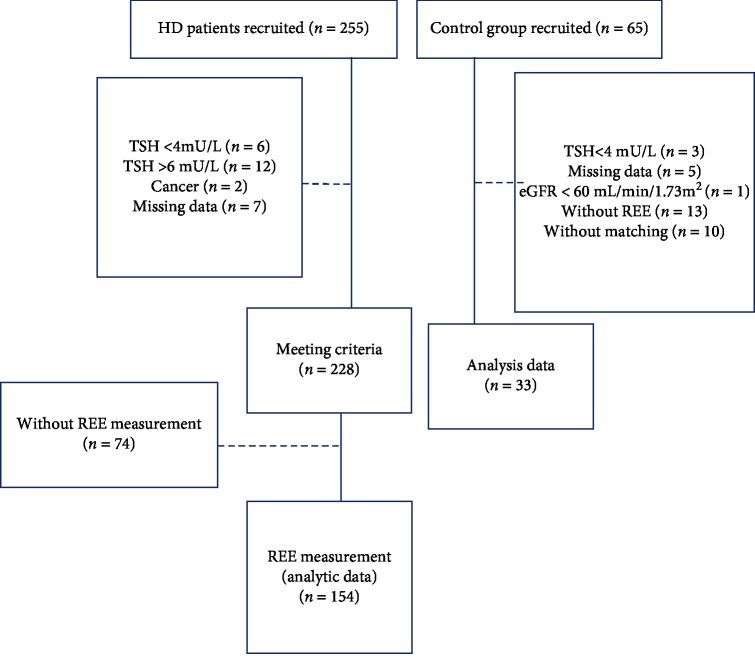
Participant group allocation process. HD: hemodialysis, TSH: thyroid-stimulating hormone, and REE: resting energy expenditure.